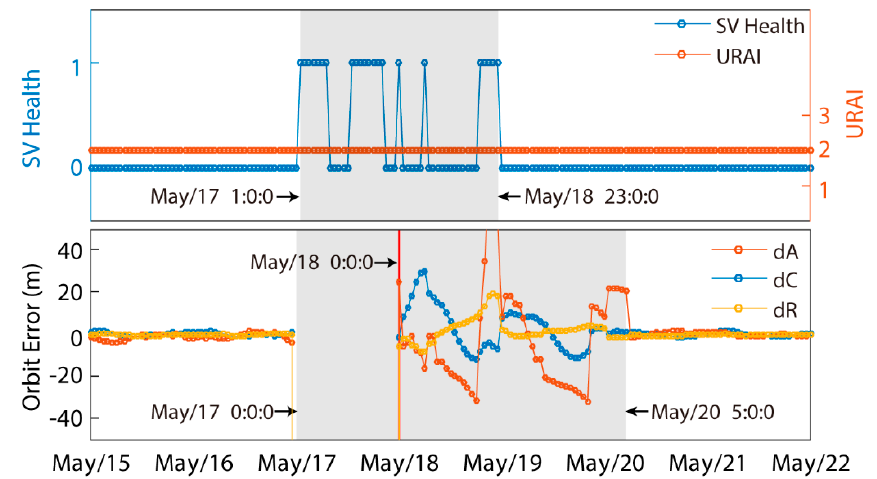
Figure 4. The User Range Accuracy Index (URAI), space vehicle (SV) health (Top) and orbit error (Bottom) time series of C07 broadcast navigation messages from May/15 to May/22 in 2016.